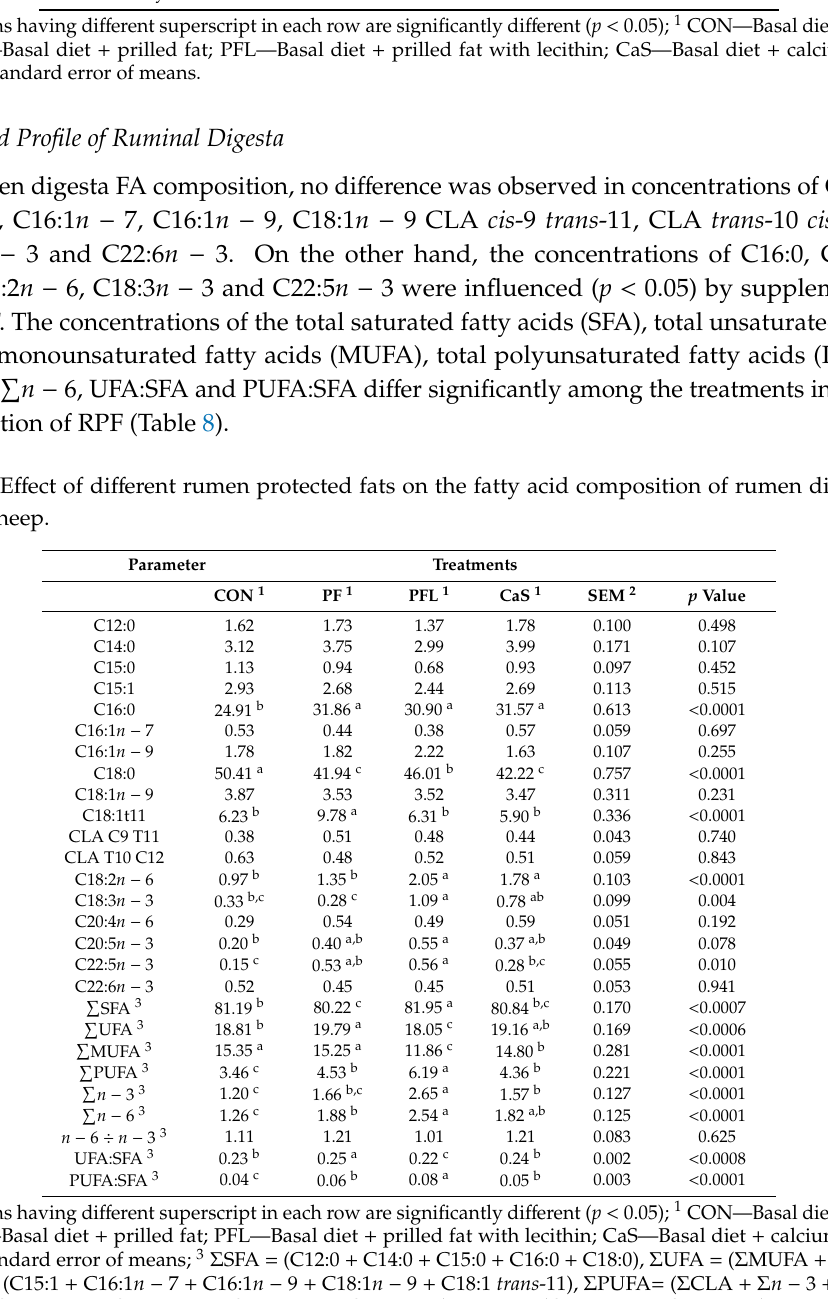
Ruminococcus flavefaciens